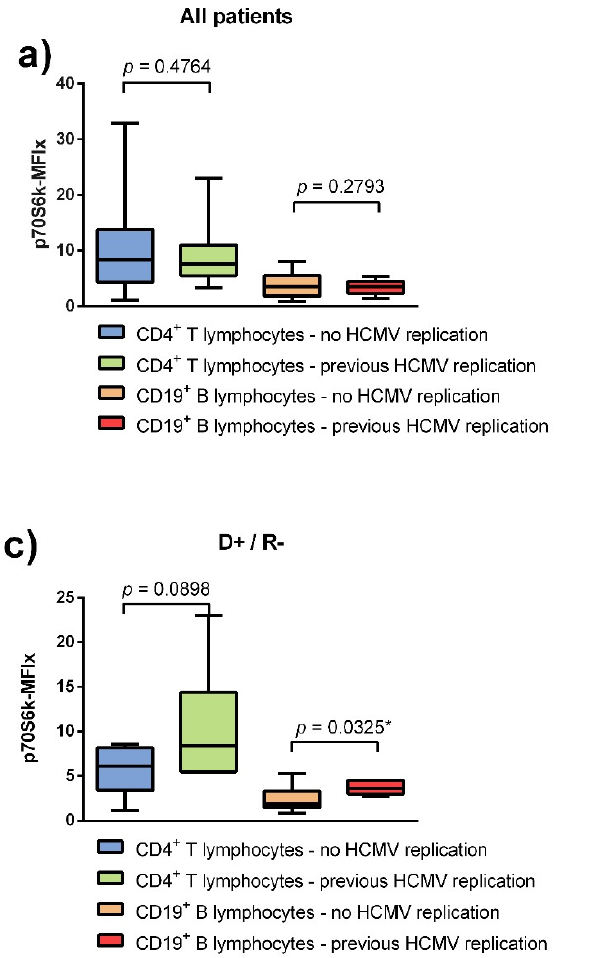
Figure 2. HCMV reactivation is only linked to increased p70S6k phosphorylation in renal transplant recipients with a high-risk constellation of donor and recipient. ( a ) Without differentiating between HCMV risk categories, no significant difference in p70S6k phosphorylation could be found between renal transplant recipients with ( n = 16) and without ( n = 32) prior episodes of HCMV DNAemia. For CD4 + T lymphocytes, the median p70S6k phosphorylation was 8.33 (IQR = 4.39 to 13.77) in patients without HCMV reactivation and 7.6 (IQR = 5.47 to 11.01) for patients with prior HCMV reactivation ( p = 0.4764). For CD19 + B lymphocytes the median p70S6k phosphorylation was 3.54 (IQR = 1.84 to 5.52) in patients without HCMV reactivation and 3.53 (IQR = 2.30 to 4.56) for patients with prior HCMV reactivation ( p = 0.2793). ( b ) For the subgroup of renal transplant recipients with an intermediate risk for HCMV no significant difference in p70S6k phosphorylation could be found between patients with ( n = 10) and without ( n = 11) prior reactivation of HCMV. For CD4 + T lymphocytes the median p70S6k phosphorylation was 8.87 (IQR = 4.25 to 15.16) in patients without HCMV reactivation and 7.21 (IQR = 4.56 to 10.35) for patients with prior HCMV reactivation ( p = 0.4222). For CD19 + B lymphocytes the median p70S6k phosphorylation was 3.65 (IQR = 2.51 to 5.62) in patients without HCMV reactivation and 3.53 (IQR = 1.74 to 5.11) for patients with prior HCMV reactivation ( p = 0.1716). ( c ) In the subgroup of renal transplant recipients with a high risk for HCMV, those with episodes of HCMV DNAemia in their medical history ( n = 6) had a significantly increased p70S6k phosphorylation in CD19 + B lymphocytes but not in CD4 + T lymphocytes compared to patients without any history of HCMV reactivation ( n = 6). For CD4 + T lymphocytes the median p70S6k phosphorylation was 6.13 (IQR = 3.43 to 8.15) in patients without HCMV DNAemia and 8.4 (IQR = 5.49 to 14.41) for patients with prior HCMV infection ( p = 0.0.0898). For CD19 + B lymphocytes the median p70S6k phosphorylation was 1.85 (IQR = 1.47 to 3.28) in patients without HCMV DNAemia and 3 3.62 (IQR = 2.97 to 4.56) for patients with prior HCMV infection ( p = 0.0325). The bar charts show the medians with IQR of the phosphorylation of p70S6k. Mann–Whitney-U-Test was used to determine significance (* p <